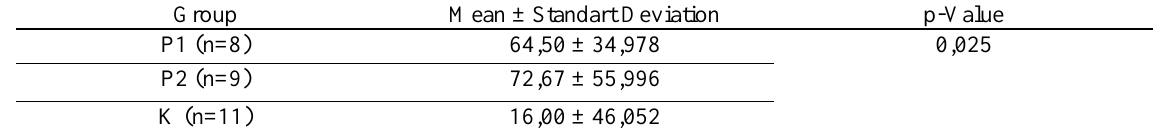
Table 4 Effectiveness between treatment groups 1, 2, and control